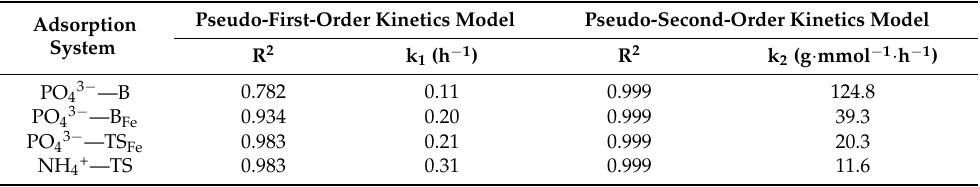
Table 3. Correlation factors (R 2 ) and velocity constants (k 1 and k 2 ) of the pseudo-first-order kinetics model and the pseudo-second-order kinetics model.